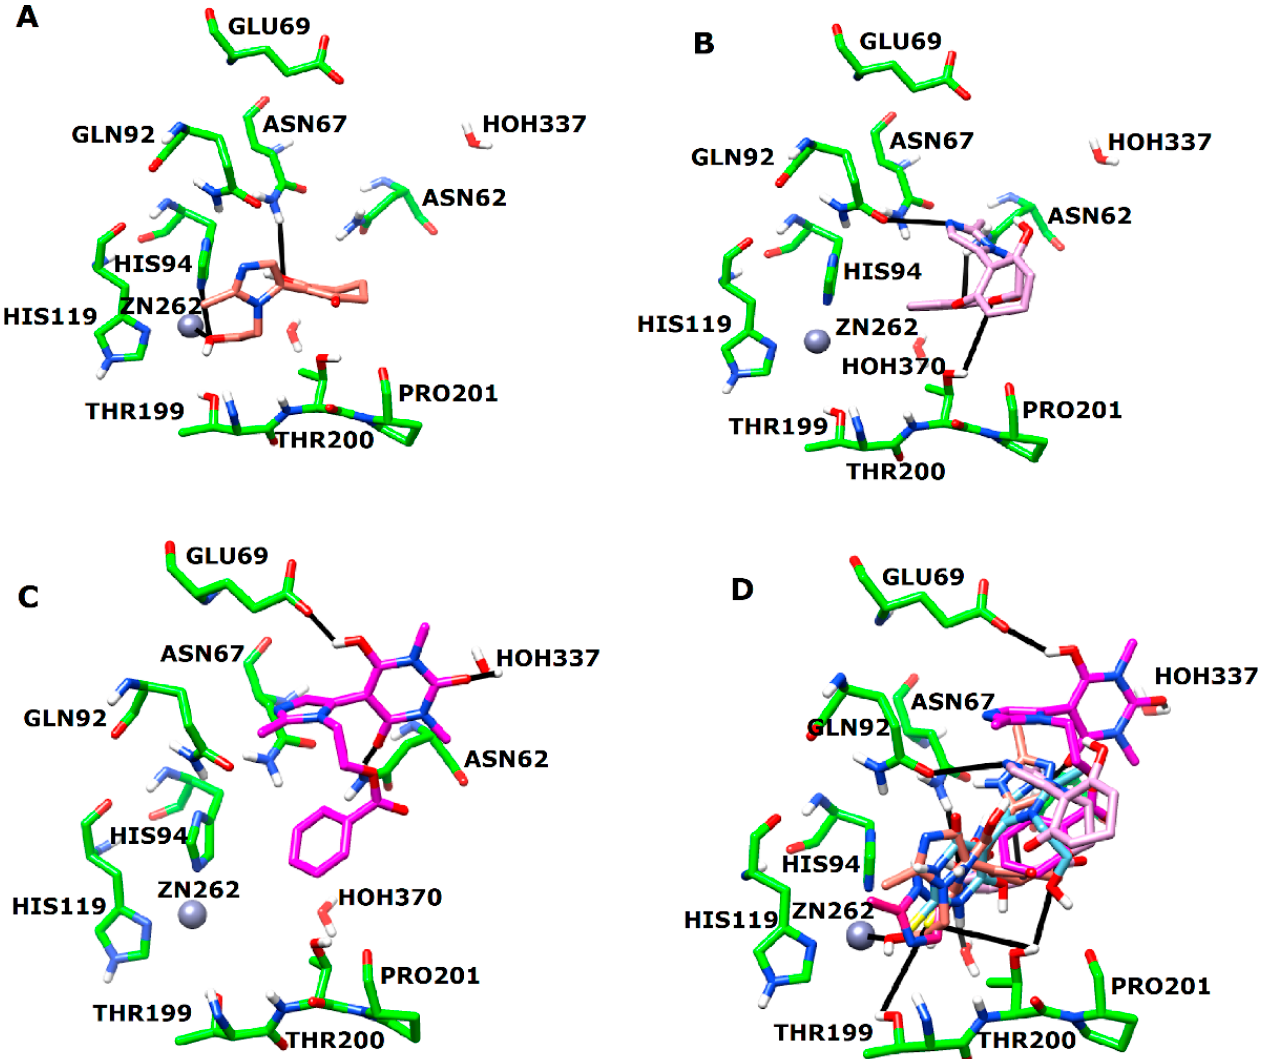
Figure 6. The docked poses of the active compounds in the active site of hCA-II. ( A – C ) The binding interactions of most active compounds 1 , 2 , and 4 are shown. ( D ) The binding interactions of all the inhibitors at the active site of hCA-II are shown. In the active site, Zn is presented as a slate blue sphere, ligands are depicted in different colors in stick models, active site residues are presented in green stick models, and H-bonds are presented in black lines.